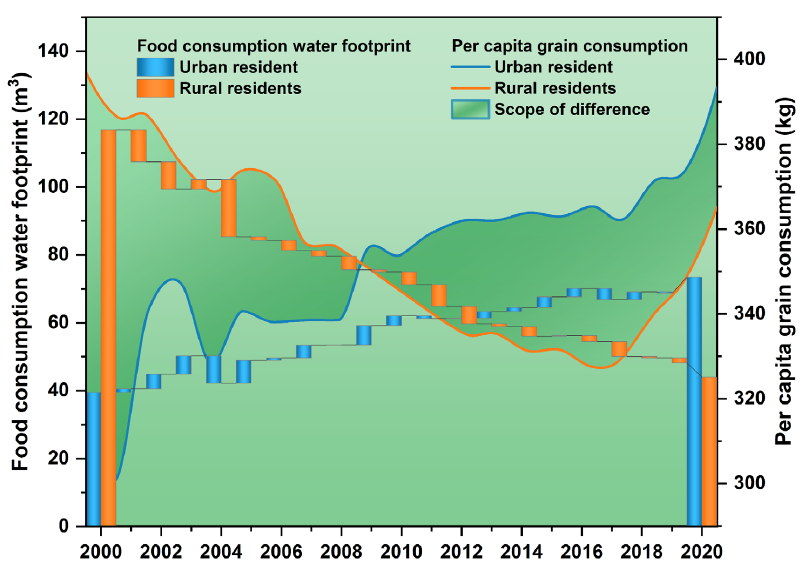
Figure 6. Water footprint of grain consumption by urban and rural residents in Northwest